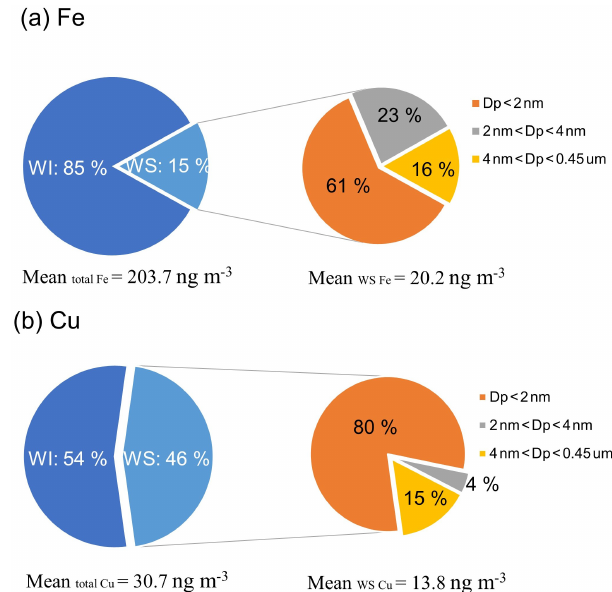
Figure 5. Components of PM 2 . 5 (a) Fe and (b) Cu. Water-soluble (WS) species are operationally defined by samples that pass through a 0.45µm pore syringe filter (shown in light blue). Water-insoluble (WI) species are defined by the difference in all (total) species of that metal and WS species (shown in dark blue). WS Fe (a) and WS Cu (b) concentrations were further separated in ultrafiltration via 30000 or 3000Da ultrafiltration filters (roughly corresponding to particle sizes of 4 and 2nm, respectively). Concentrations in differ- ent size ranges were determined by difference (statistics calculated on the